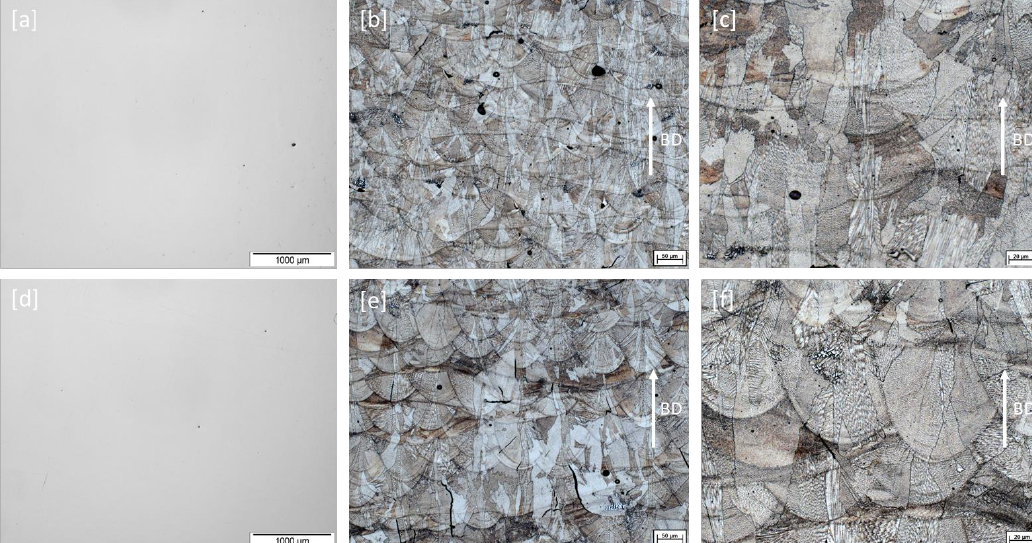
Figure 4. LOM micrographs of 140 µ m hatch distance print set: ( a ) unetched, dense as-built cube (scanning speed 550 mm / s); ( b , c ) etched with CuCl 2 showing epitaxial growth and columnar grain formation; ( d ) unetched, dense as-built cube (scanning speed 850 mm / s); ( e , f ) etched with CuCl 2 also showing epitaxial growth and columnar grain formation.